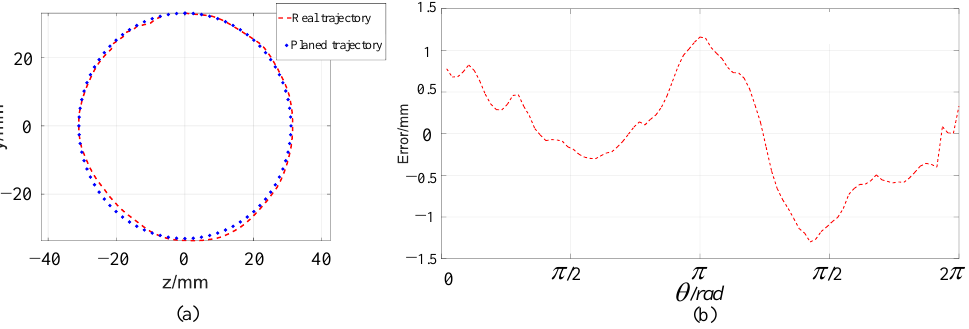
Figure 19. Circle trajectory following experiments of the single arm. ( a ) Trajectory following exper- iment, ( b ) Trajectory following error.